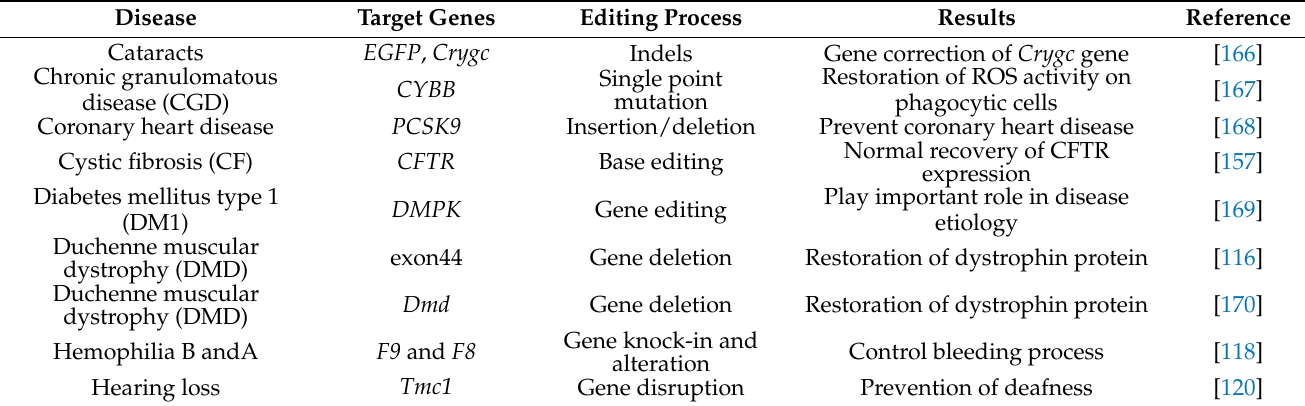
Table 6. The application of CRISPR–Cas in therapeutics. Abbreviations: HBV, hepatitis B virus; IE protein, immediate early protein; RBC, red blood cells; ROS, reactive oxygen species.